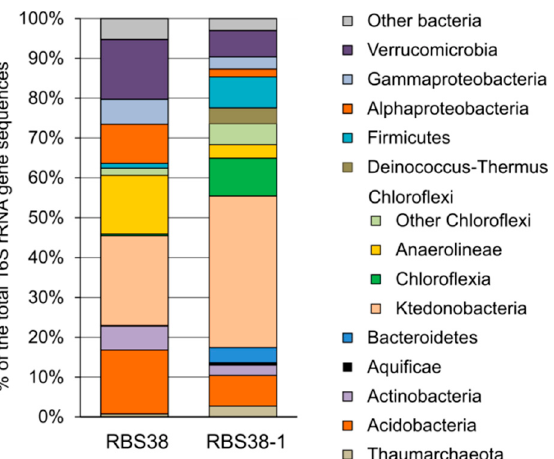
Figure 3. The relative abundance of taxonomic groups of microorganisms according to 16S rRNA gene profiling. “Other bacteria” comprises all reads not assigned to mentioned phyla (details are provided in Supplementary Table S1).